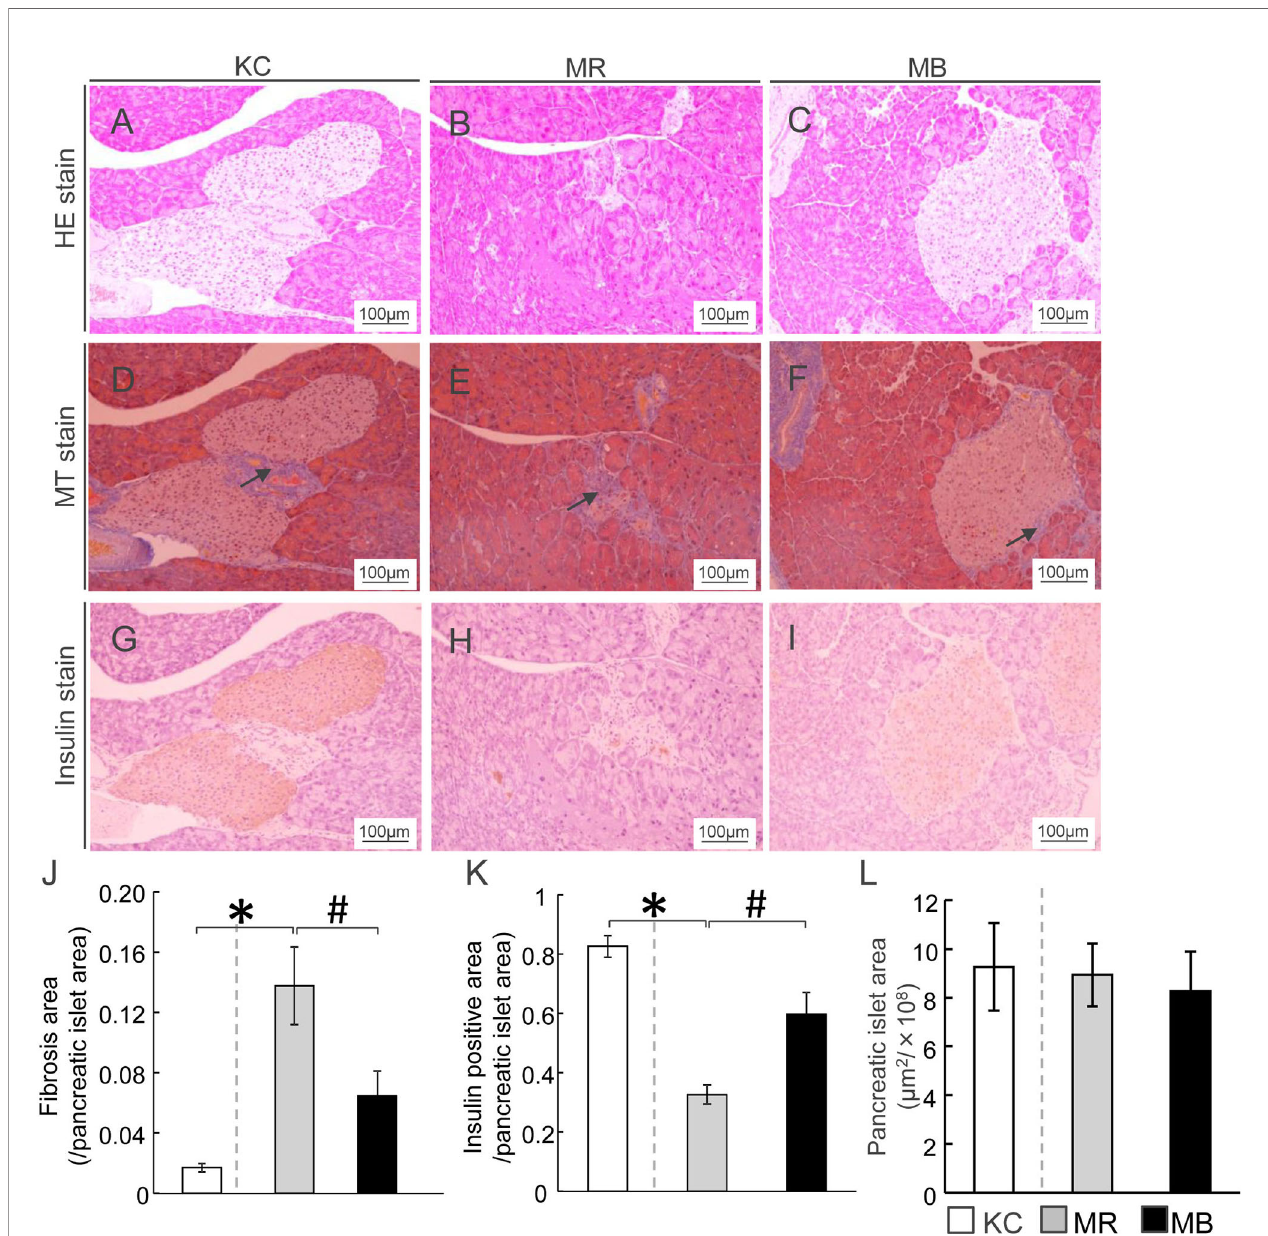
FIGURE 1 | b -Cell area in mice after 10 weeks of experimental diet intake. (A – C) Representative histological hematoxylin-eosin staining of pancreatic sections from mice from each of the three experimental groups. (D – F) Fibrotic areas in the pancreas within the islets were stained blue after Masson ’ s trichrome staining (arrows). (G – I) Insulin-positive areas within the islets are stained brown (scale bar, 100µm). Ratio of areas with fi brosis (J) and insulin-positive cells (K) in the pancreatic islets and area of pancreatic islets (L) . MB, minimum essential medium (MEM) mice on a barley diet; MR, MEM mice on a rice diet; KC, potassium simplex optimized medium control mice on a rice diet. Data are expressed as the mean ± SEM for 8 – 12 animals. Data were analyzed using Student ’ s t -test. * P < 0.05 compared with the KC group; # P < 0.05 compared with the MR